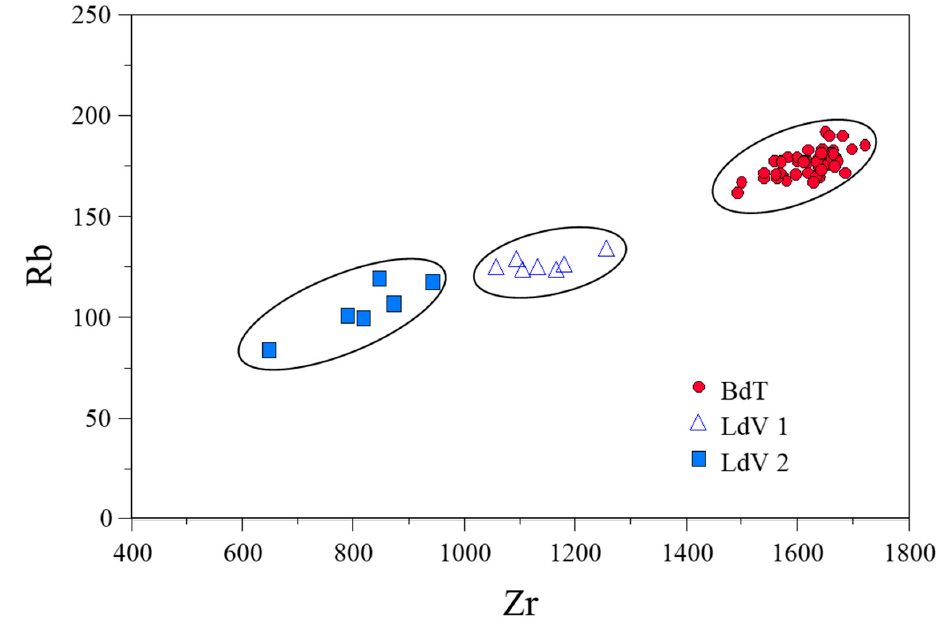
Figure 9. Pantelleria is separated by Balata dei Turchi (BdT), and both Lago di Venere (LdV) 1 and